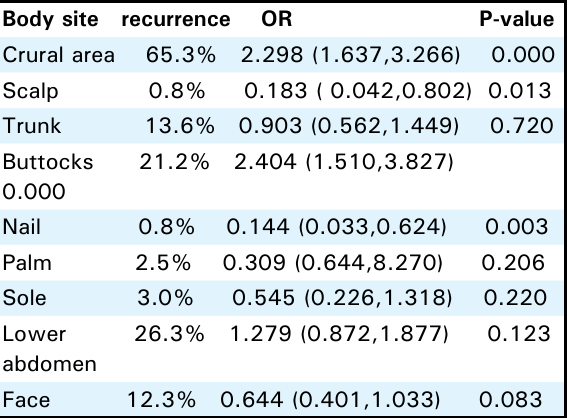
Table 5. risk of recurrence at various body